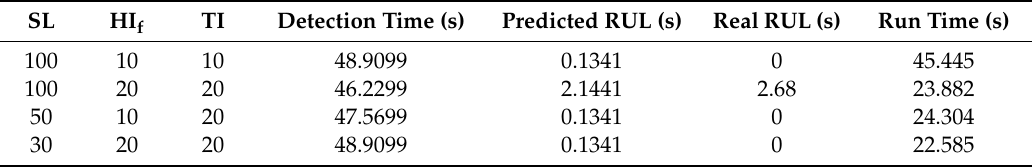
Table 2. Comparison of the state space model (SSM) performance with di ff erent input parameter sets. SL HI f TI Detection Time (s) Predicted RUL (s) Real RUL (s) Run Time (s)